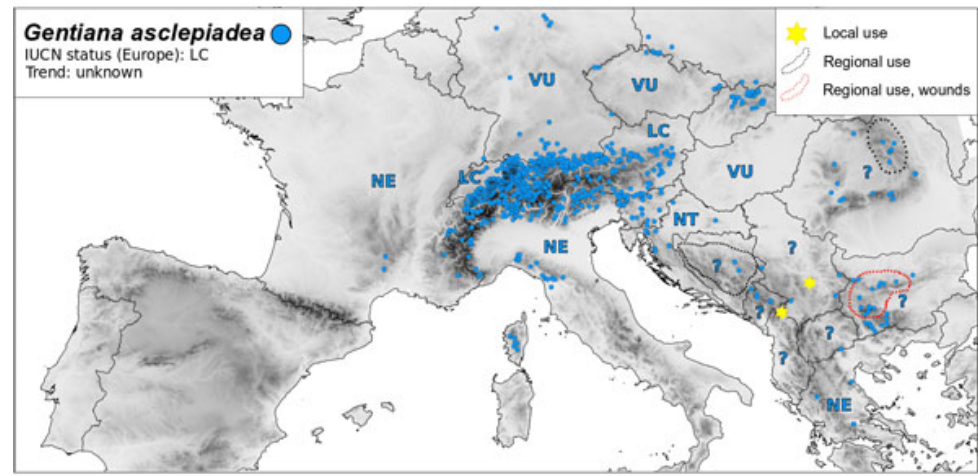
Figure 4. Map of distribution G. asclepiadea— conservation status and medicinal use, Legend: IUCN status—Least Concern (LC); Near Threatened (NT); Vulnerable (VU); Endangered (EN); Critically Endangered (CR); and Not Evaluated (NE).